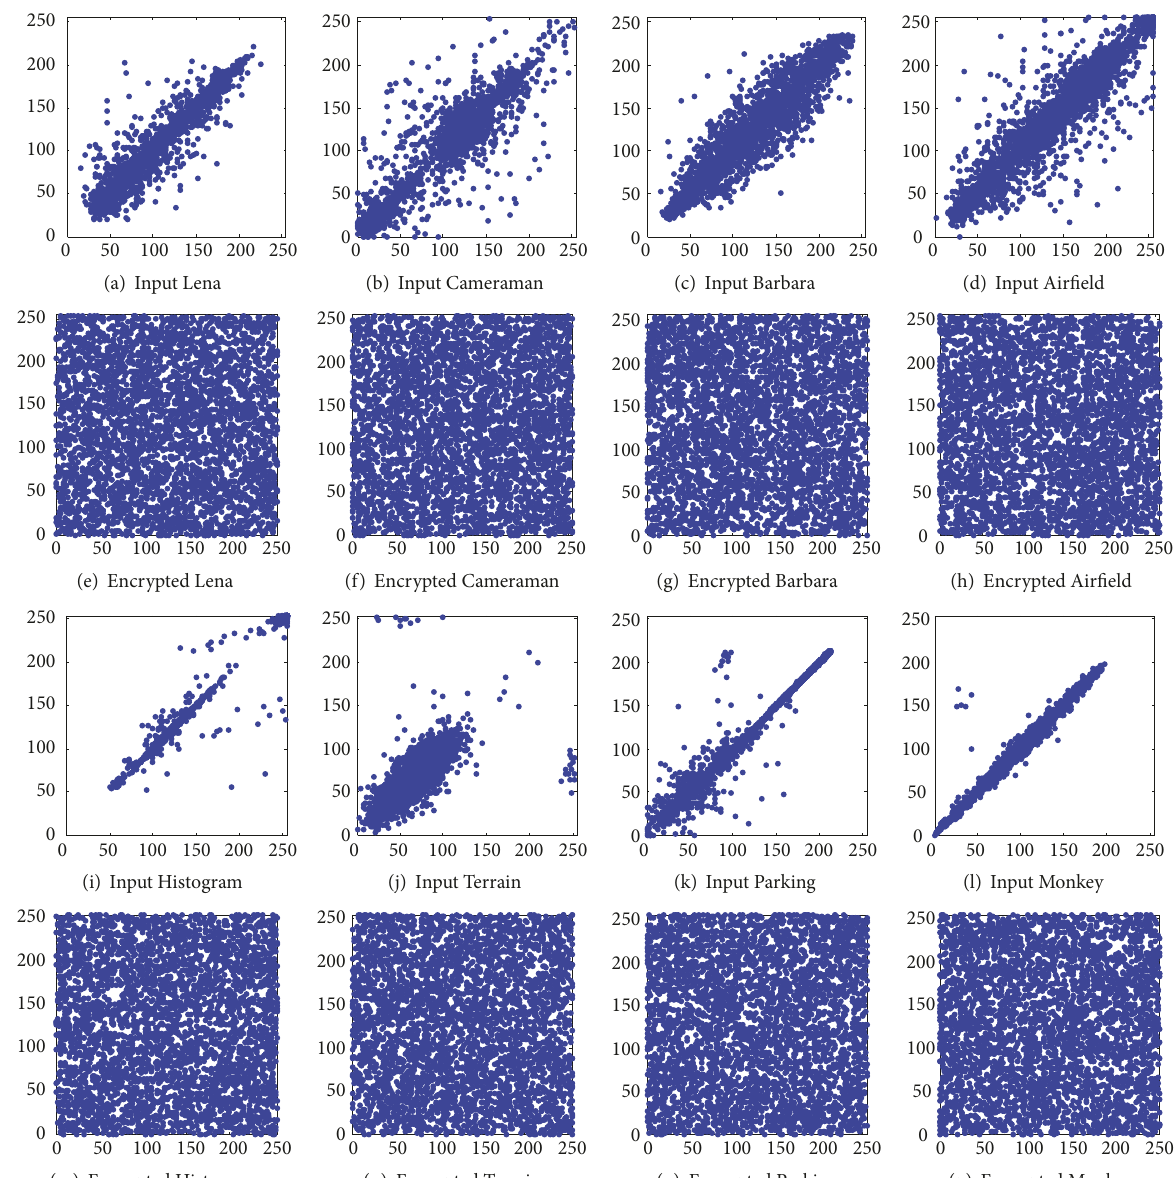
Figure 9: The adjacent-pixel distribution maps of the input images and the corresponding encrypted images in horizontal direction.